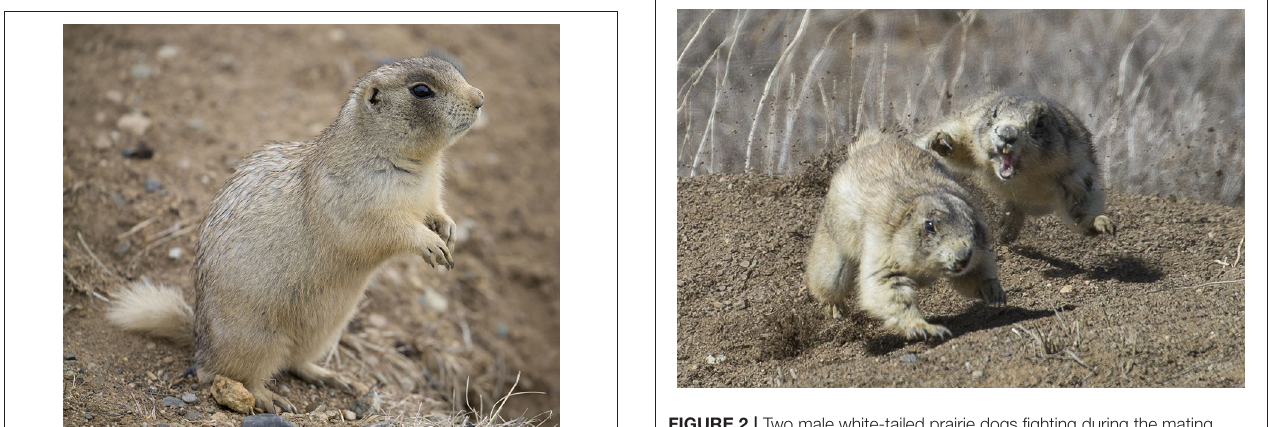
FIGURE 2 | Two male white-tailed prairie dogs fighting during the mating season in April at the Arapaho National Widlife Refuge, Colorado. Males that win fights and chases are better able to monopolize, and copulate with, estrous females. Photo by Elaine Miller Bond, www.elainemillerbond.com (Reproduced with